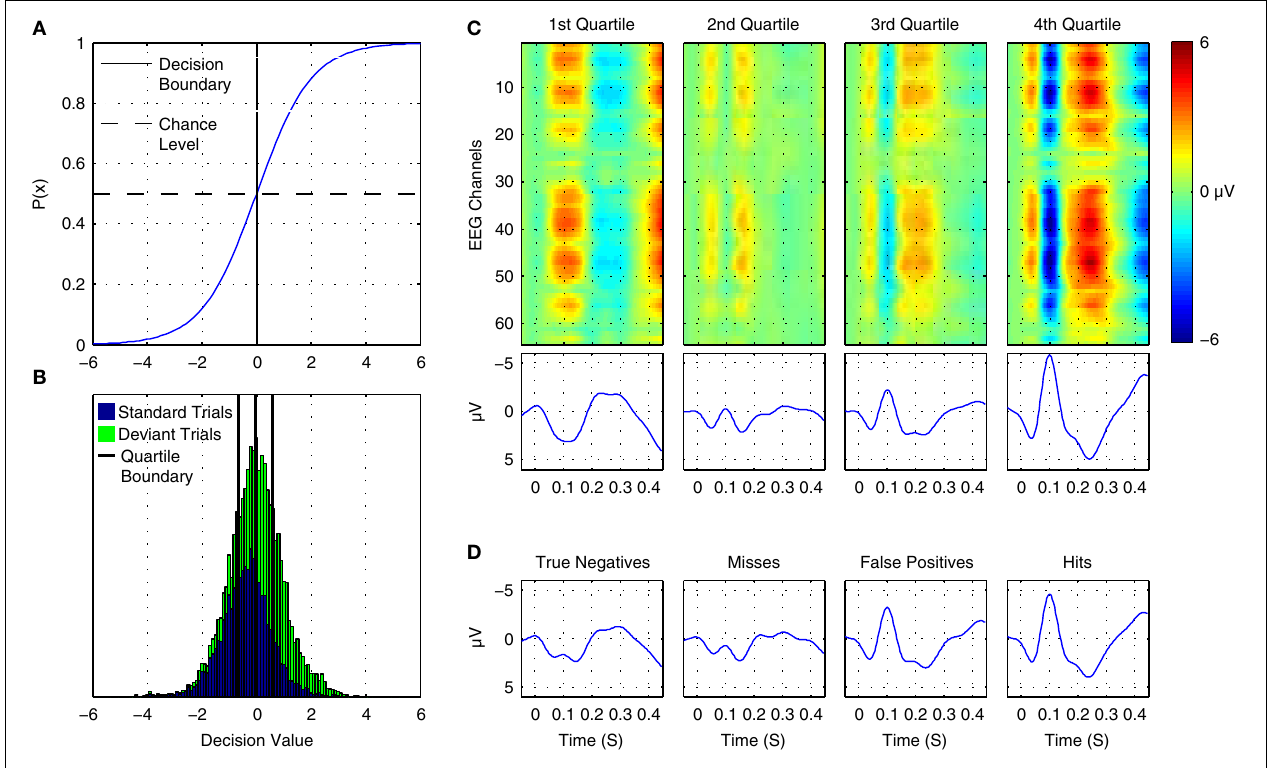
FIGURE 12 | Online tracking of single trial brain activity in an auditory mismatch paradigm. (A) The logistic regression function. (B) Sorted single-trial classifier decisions for test set data in the cross-participant analysis of Dataset 1 (see Figure 11A , upper panel). A division of the trials into quartiles on the basis of the decision values is shown using thick black lines. (C) Grand average ERPs for sorted single-trial data in each quartile. Upper panels show ERP activations at all 64 EEG channels, while the lower panels show the averaged waveforms obtained at nine fronto-central